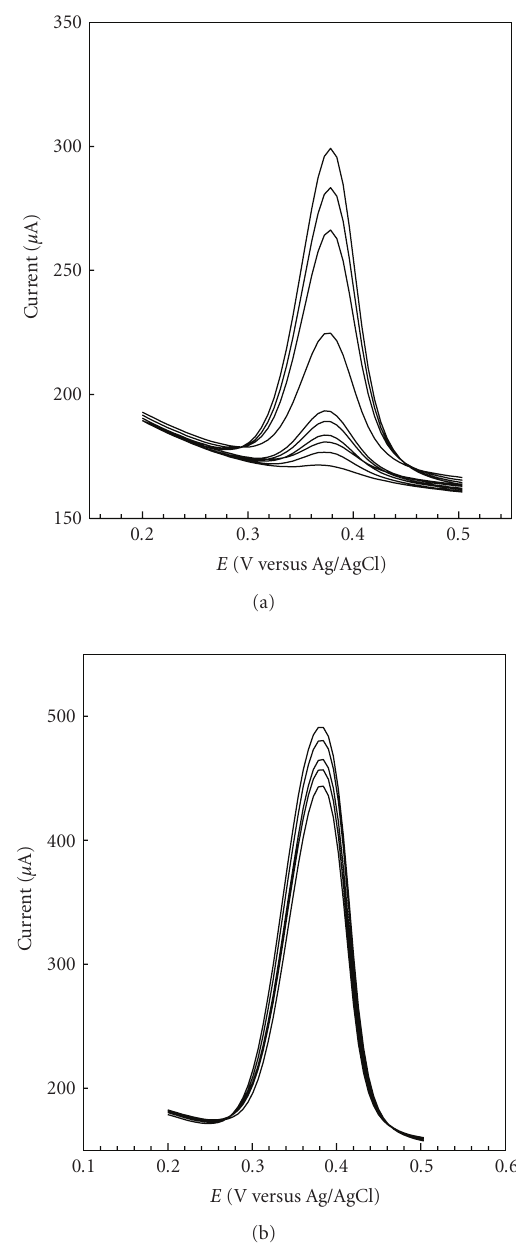
Figure 6: Di ff erential pulse voltammograms of 0.1 M phosphate bu ff er solution containing various concentrations of AC (down to up); (a) 0.2, 0.4, 0.5, 0.6, 0.8, 1, 2, 4, 5, and 6 and (b) 40, 50, 60, 80, and 100 μ M AC. Pulse amplitude was 50 mV. Accumulation time was 120